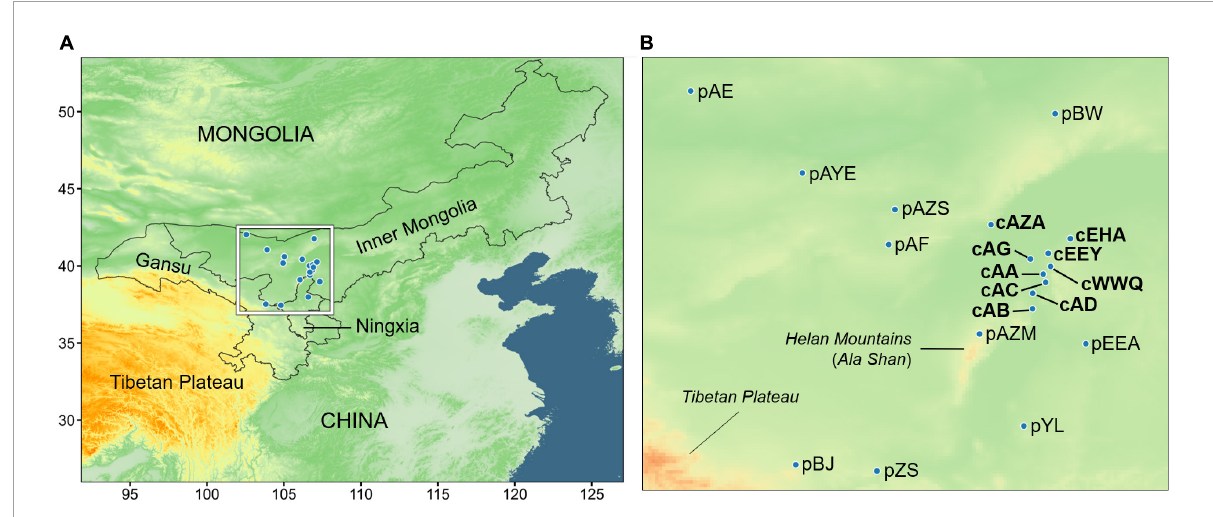
FIGURE1 The sampling sites and the climate cohorts. (A) Geographic distribution of sampling sites covering three provinces (or autonomous regions) in northern China. (B) A close-up of the inner frame of panel (A)